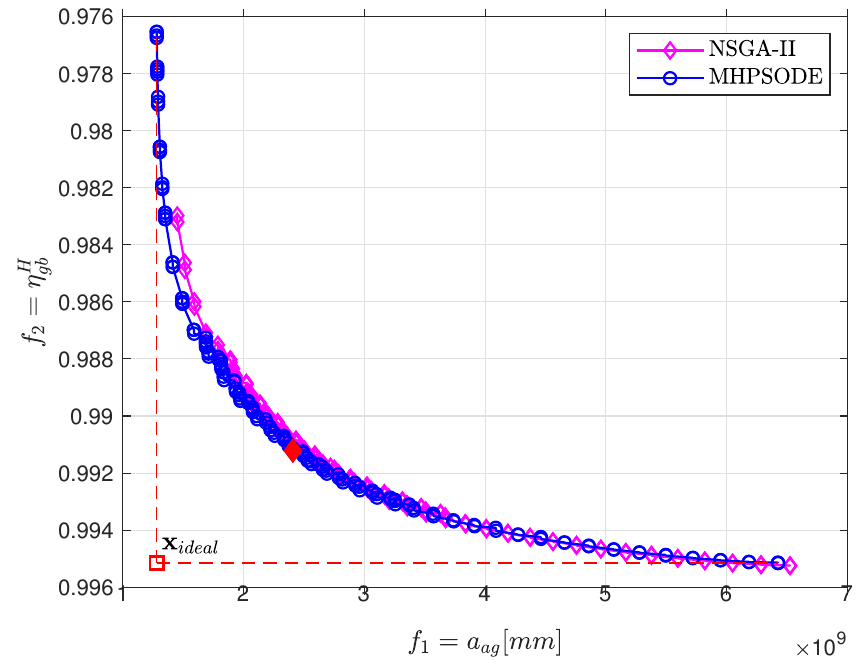
Figure 6. The obtained Pareto frontier for the volume of the gears and planetary gearbox efficiency as